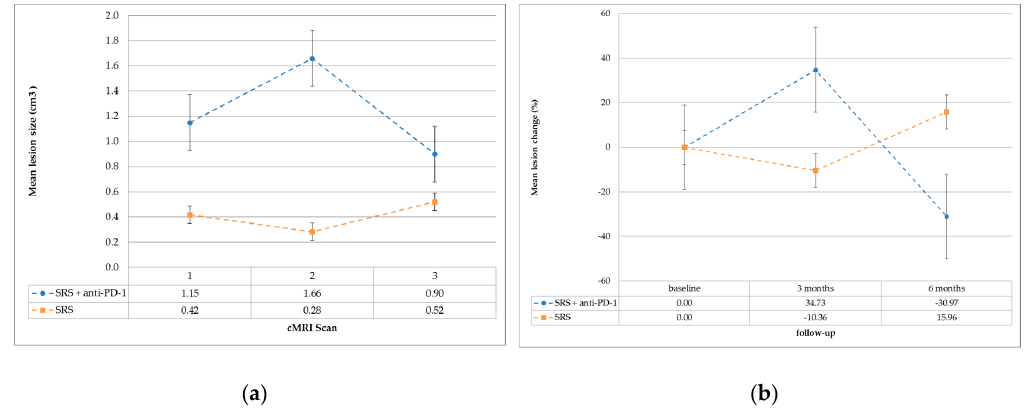
Figure 2. ( a ) Mean lesion size in cm 3 (standard error bars) at cranial MRI (cMRI) scans 1, 2 and 3. ( b ) Mean lesion change in percentage (standard error bars) before CK (Cyberknife ® ) treatment (baseline), after three and after six months follow-up.